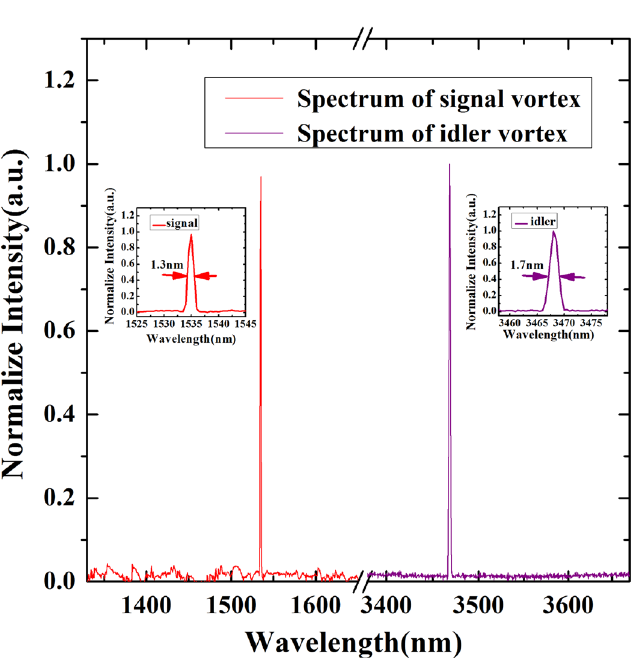
Figure 3. Spectrum of the signal and idler vortex outputs at the wavelength of 1.535 µm and 3.468 µm, respectively. Insets show the spectral bandwidth of the signal and idler vortex